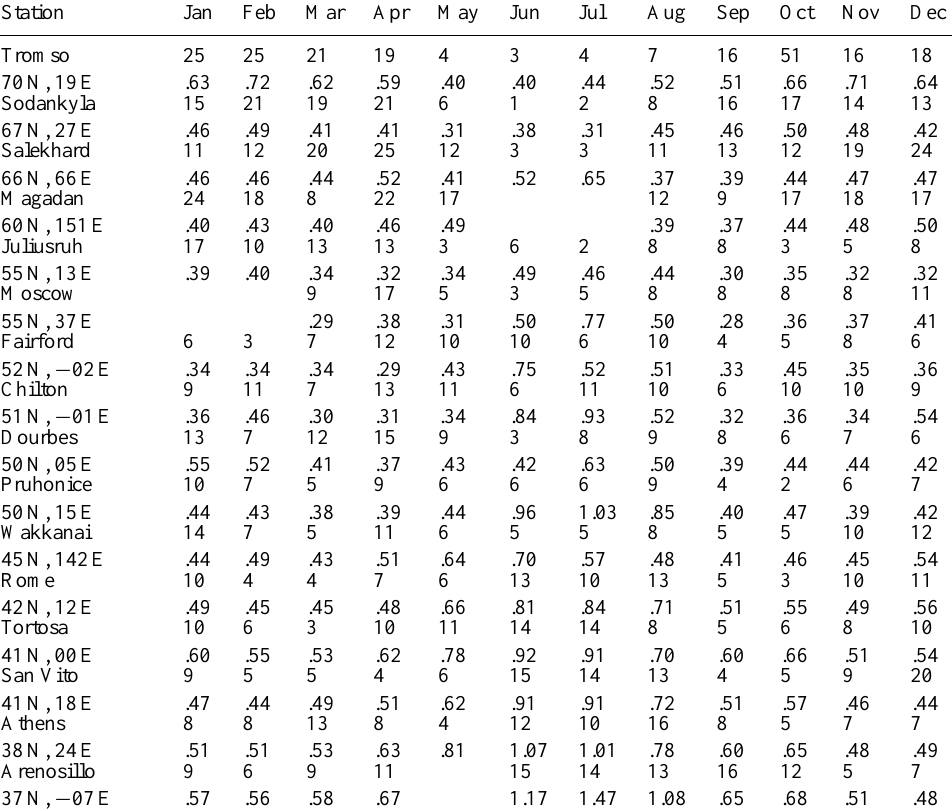
Table 1. Percentage of foF2 storm times and monthly standard deviation of foF2, MHz, during